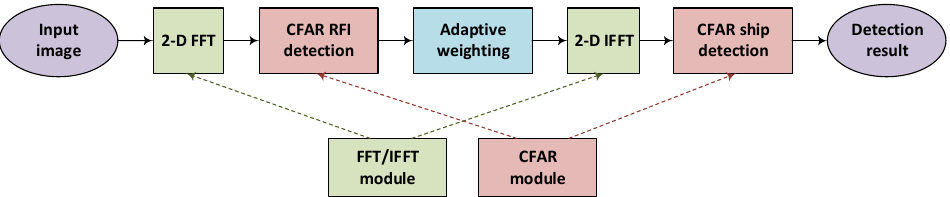
Figure 1. The processing flow for ship detection from SAR image acquired under a narrowband RFI